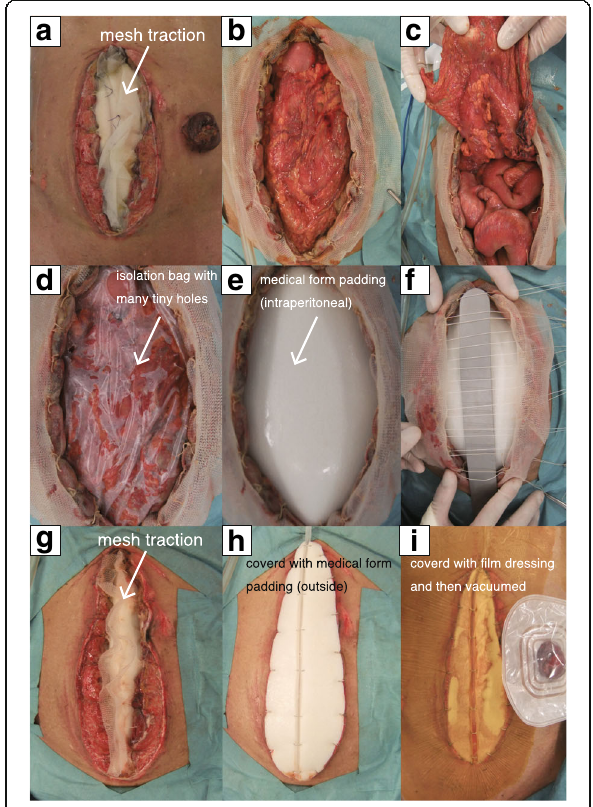
Fig. 6 Findings at the fourth operation. Abdominal distension and gut edema had decreased. a Abdominal distension had decreased. b , c Gut edema also had decreased. d - i NPWT with mesh fascial traction was performed